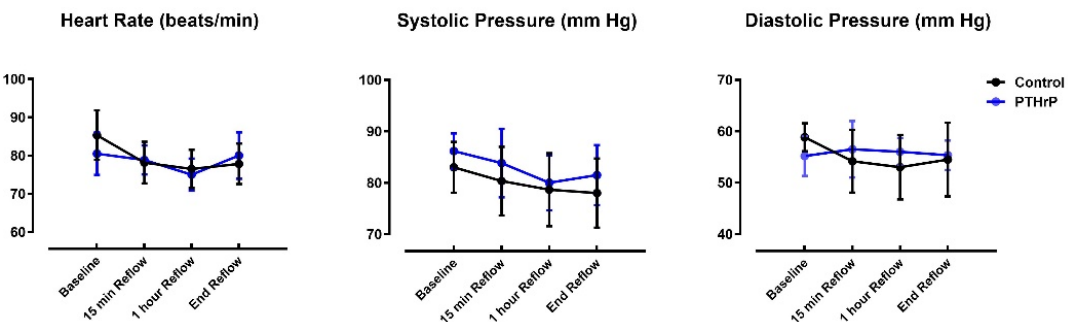
Figure 5. Heart rate, systolic and diastolic pressures, measured at baseline, 15 min, 1 h and 3 h (end) following reperfusion in PTHrP(1-36)-treated pigs and vehicle-controls. Data reported as mean ± SEM; no significant differences between groups.